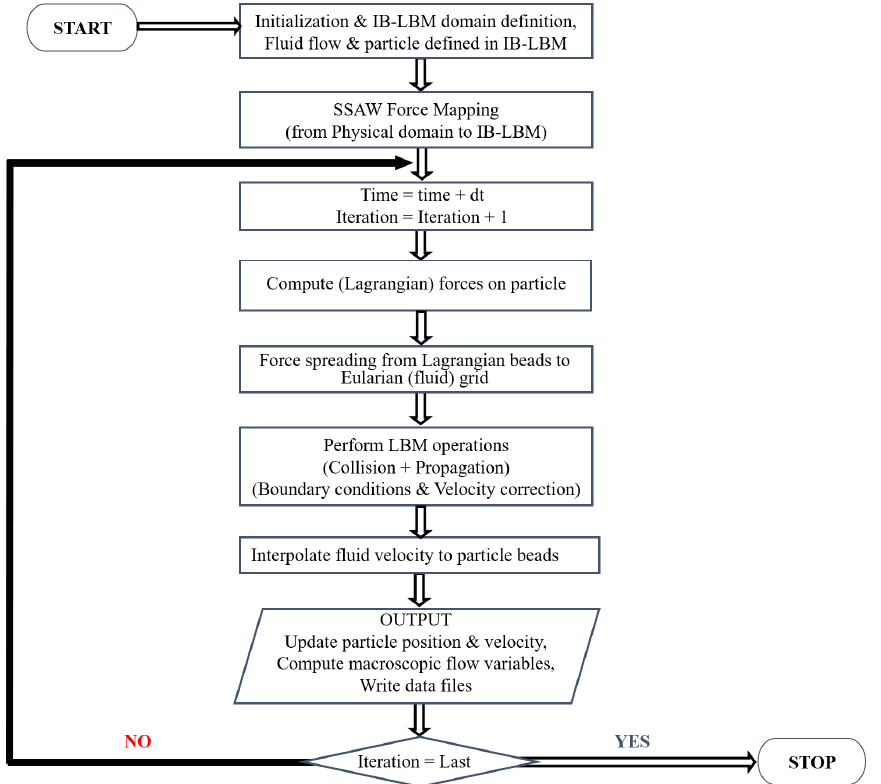
Figure 2. The flow chart diagram depicting the algorithm implemented in the current work.